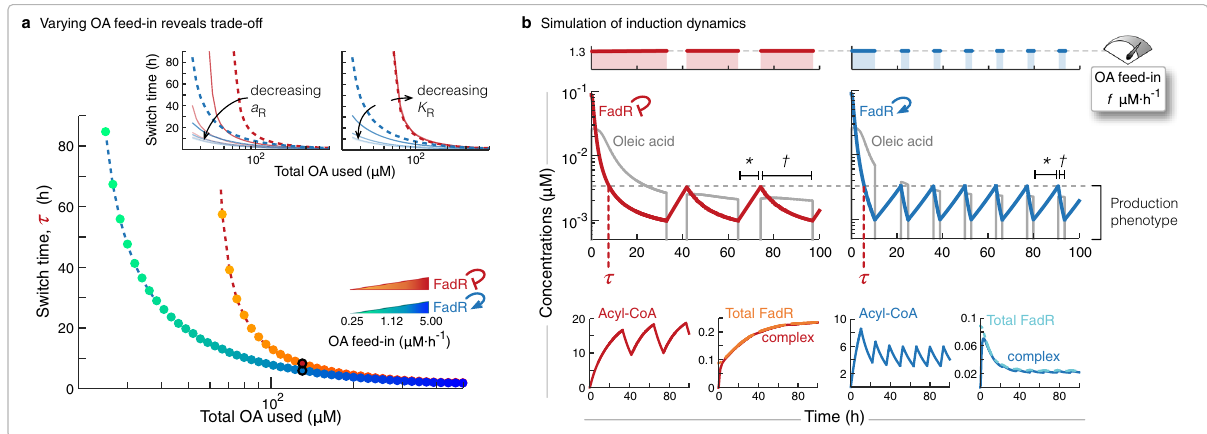
Fig. 2 Tuning inducer feed-in and control circuit to optimise induction process performance. a Plot of the two performance objectives for logarithmic increases in OA feed-in fl ux from 0.38 – 5 μ M ⋅ h − 1 , of the circuits with NAR (yellow to red dots) and PAR (green to blue dots). Inset plots show how these curves approach a limit when decreasing control circuit FadR promoter strength a R and af fi nity to bind its own promoter K R , from 100% (dashed lines) to 1% (lighter lines) of their nominal values in Supplementary Table 2. Red curves for system with NAR and blue curves for system with PAR. b Simulations of intermittent inductions of OA, at feed-in fl ux 1.3 μ M ⋅ h − 1 (top plots) to retain the production phenotype (middle plots), for the circuits with native NAR (left plots, red curves) and engineered PAR (right plots, blue curves). See Methods section for induction programme details. We plot availability of OA and dynamic response of FadR (middle plots), and dynamic responses of acyl-CoA, complex, and total FadR (free FadR + complex) (bottom plots). We calculate two induction process performance objectives from these simulations: total OA used (total shaded region in top plots) and switch time ( τ in middle plots). Asterisk and dagger in middle plots highlights the time length of subsequent recovery and induction periods.